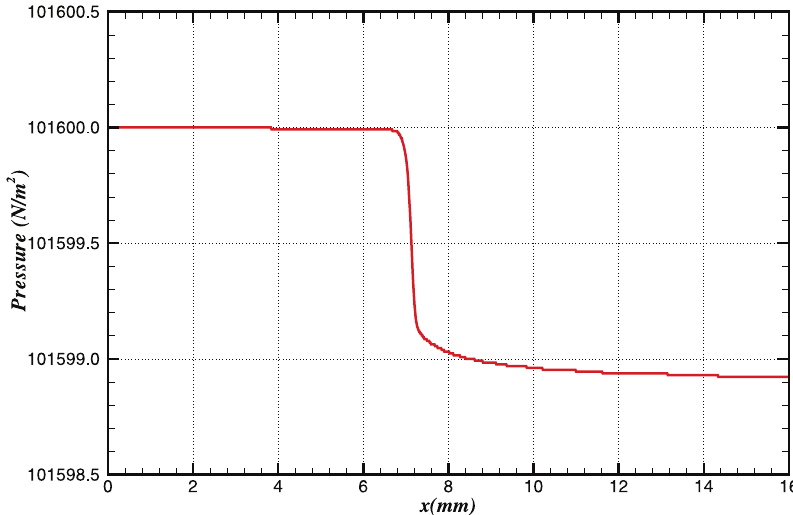
Figure 1. Steady state pressure profile in the domain.